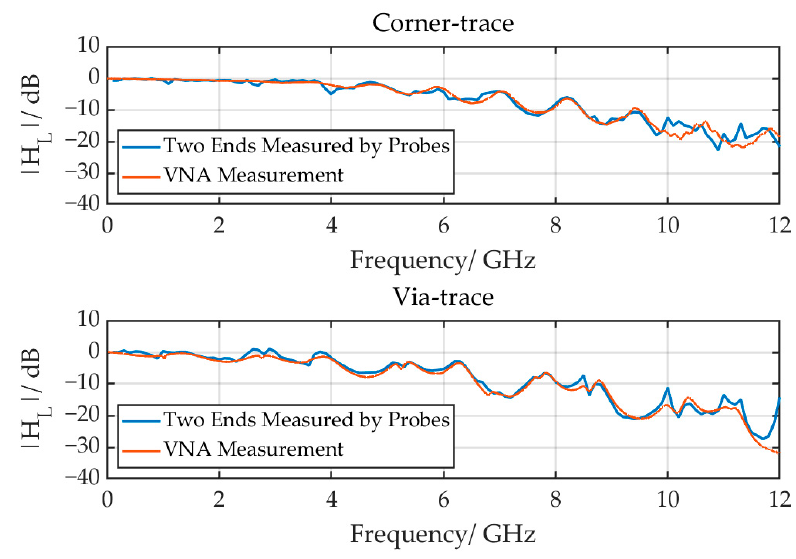
Figure 9. The extracted transmission characteristics of a corner trace and a via trace measured at both ends compared with those obtained using a VNA. When only the load side was measured, a trapezoidal waveform of 100 MHz was injected to the tested printed trace. Figure 10 depicts the amplitudes of the predicted and measured input harmonics of the above two traces. The transmission characteristics H L ( f ) acquired with the proposed method are compared with those measured using VNA in Figure 11. A wavelet packet [28] was applied to smooth the curves, as shown in Figure 12. After being processed, the transmission coefficients calculated with the proposed method agreed well with those obtained using a VNA below 12 GHz. The mean variation of the corner trace is 3.18 dB, and the maximum error is 6.7 dB at 11.3 GHz. The mean variation of the via trace is 3.52 dB, and maximum variation is 17.2 dB at 12 GHz. Except for 12 GHz, they can satisfy the requirements for engineering utilization.